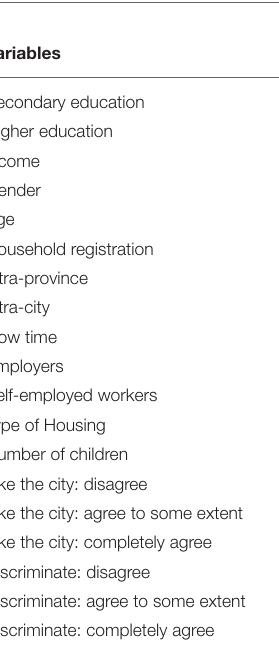
TABLE 4 | Marginal effect table of explanatory